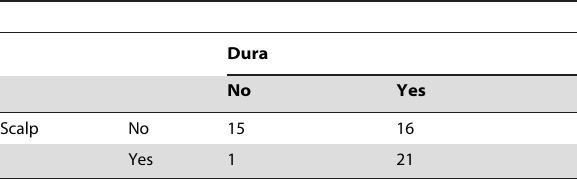
Table 1. Odds ratio of culture success: dura vs. scalp matched pairs